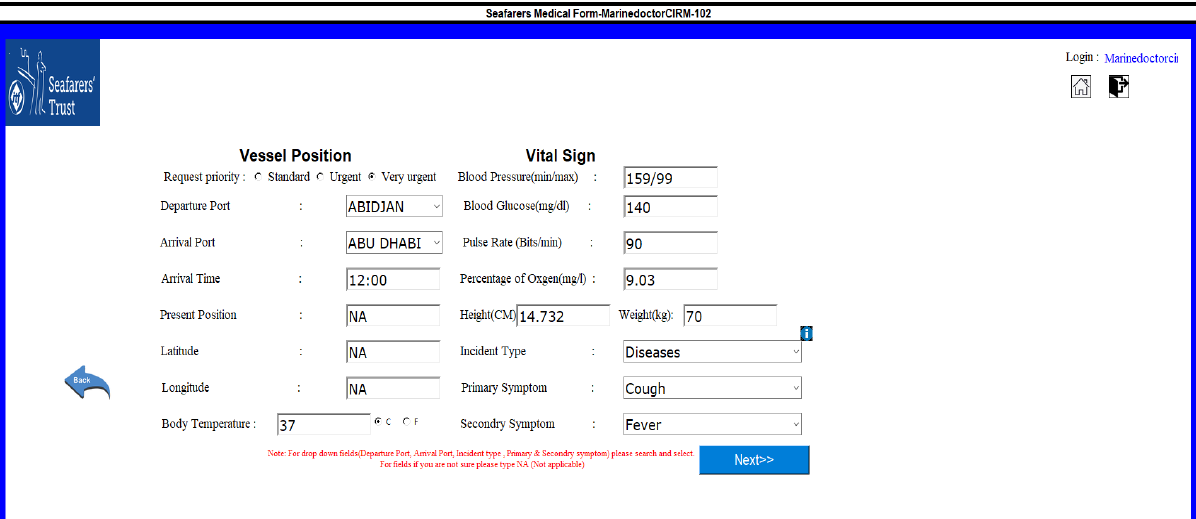
Figure 4. Form to collect ship location and patient biomedical information.